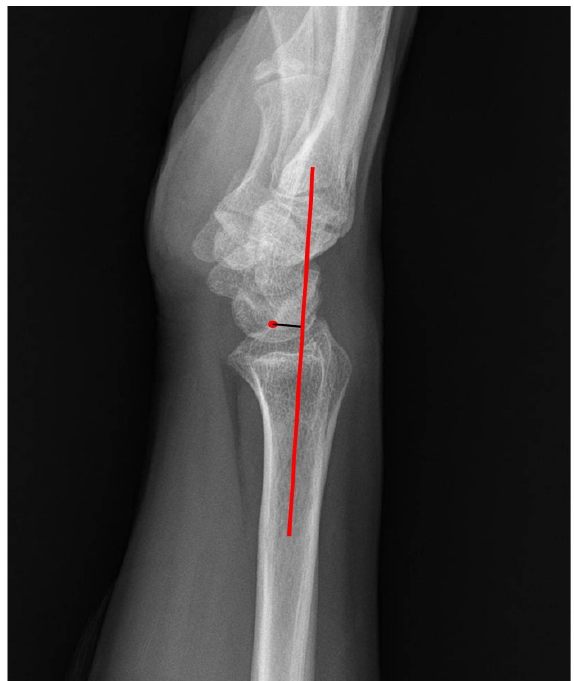
Figure 1. The LARD was defined as the perpendicular distance from the center of the lunate to the sagittal axis of the radius shaft.